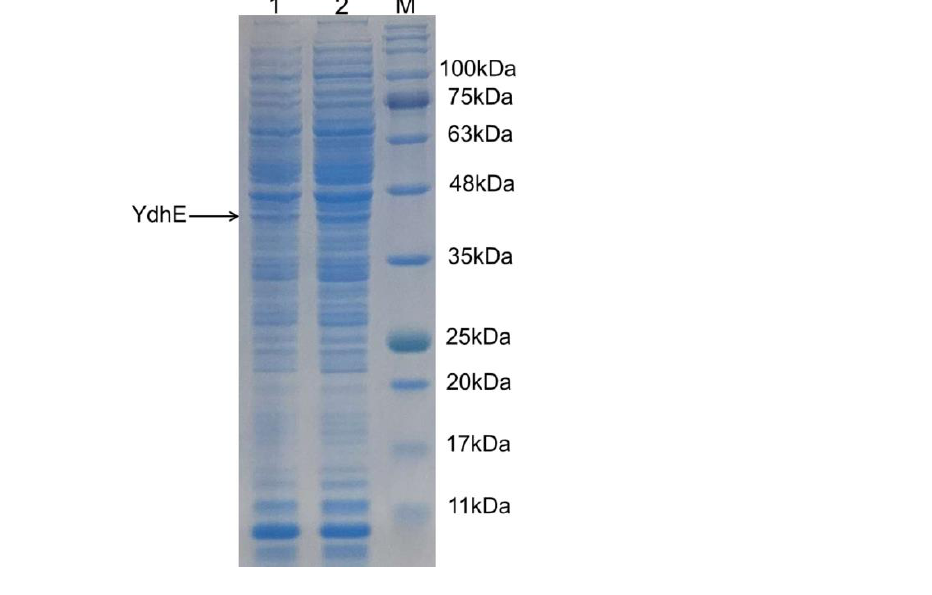
Figure 2. SDS−PAGE (12%) analysis of CO−YdhE by recombinant C. glutamicum . M; Protein mark- Figure 2. SDS − PAGE (12%) analysis of CO − YdhE by recombinant C. glutamicum . M; Protein er, lane 1: total protein of CO−YdhE in C. glutamicum ; lane 2: soluble protein of CO−YdhE in C. marker, lane 1: total protein of CO − YdhE in C. glutamicum ; lane 2: soluble protein of CO − YdhE in glutamicum . C. glutamicum